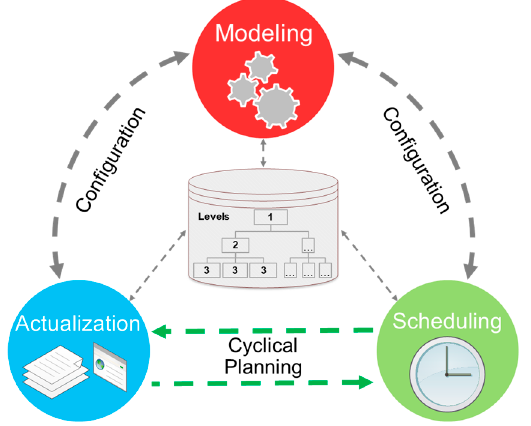
Figure 9. System view of the IT support.